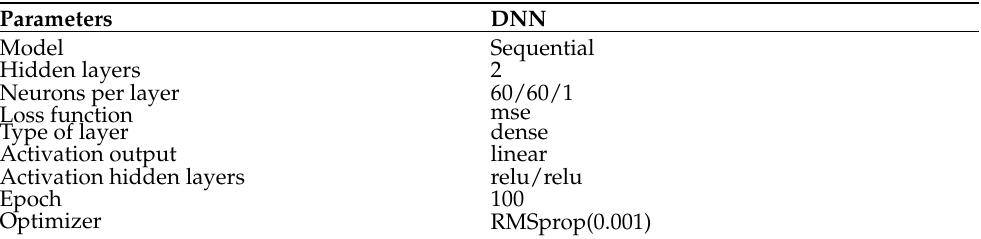
Table 4. Dense neural network